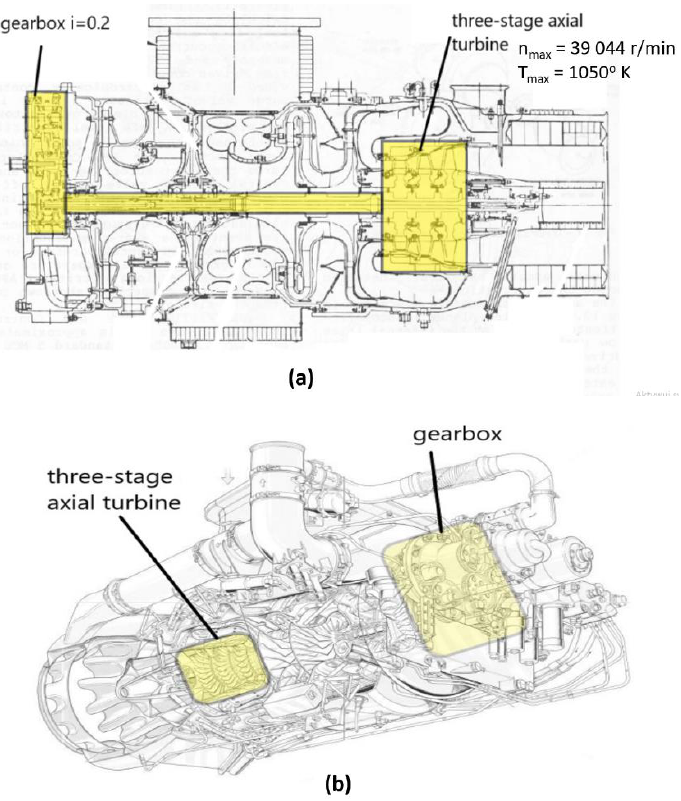
Figure 8. The GTCP331-500 engine: ( a ) cross-section; ( b ) isometric view (Adapted from [23]).